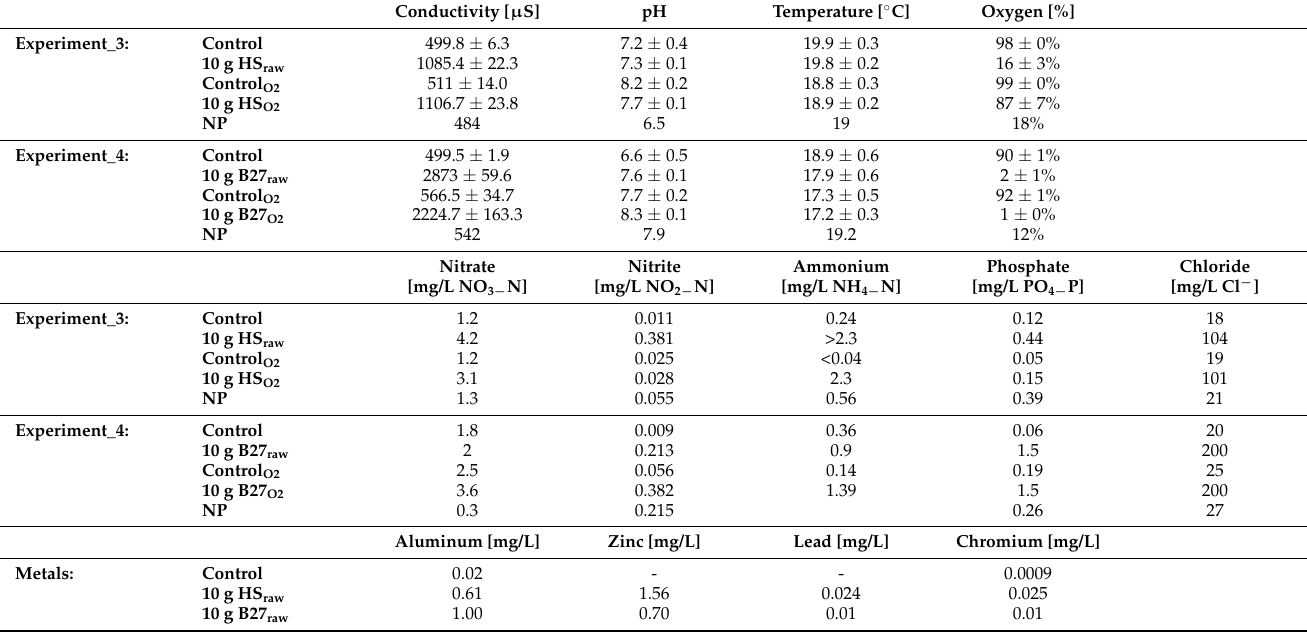
Table 2. Results of the water analysis of the eluates, recorded at 96 h in a climate-controlled chamber (20 ◦ C). Temperature [ ◦ C], O 2 [%] (Intellical LDO101 Field Luminescent/Optical Dissolved Oxy- gen (DO) Sensor (LDO10105)), pH (Intellical PHC201 Laboratory General Purposes Gel-Filled pH Electrode (PHC20103)) and conductivity [ µ S] (Intellical CDC401 Laboratory 4-Poles Graphite Con- ductivity Cell (CDC40101)) recorded with HQ40D digital two-channel multimeter (HQ40D.99.000000; multimeter and all sensors by HACH, Loveland, CO, USA). NANOCOLOR tube tests for